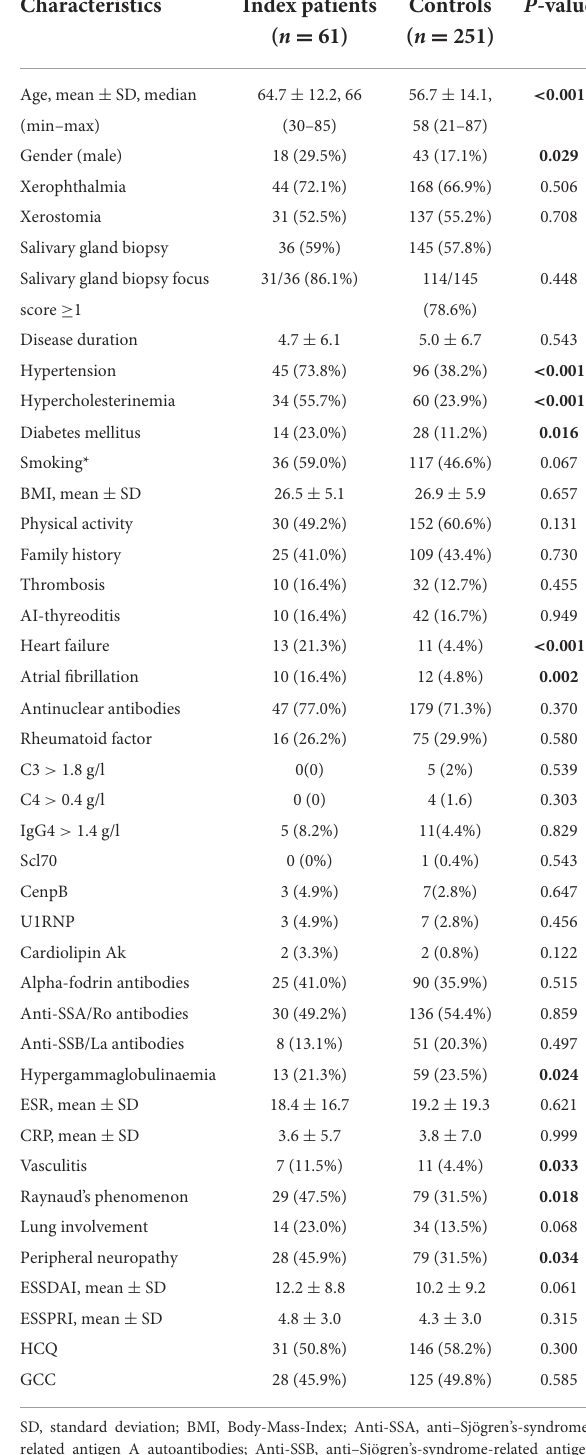
TABLE 1 General characteristics of the study population ( n = 312). TABLE 2 Comparison between pSS patients with and without cardiovascular and atherosclerotic endpoints.